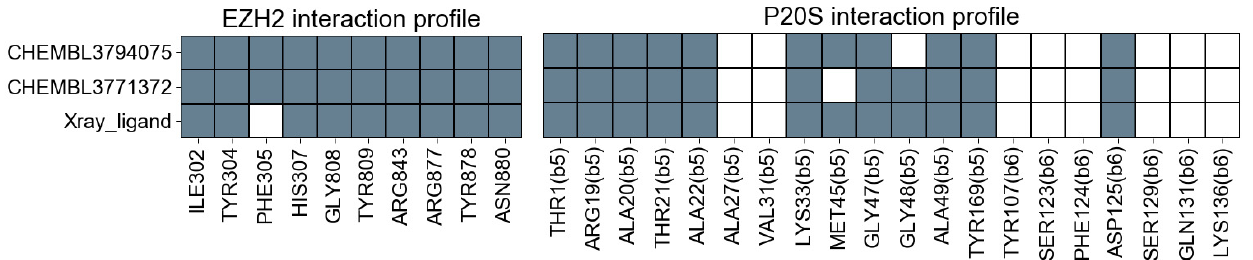
Figure 11. PLIFs profile of the contacts between the X-ray ligand and the compounds selected, and the proteins in the molecular docking simulations, calculated in Schrödinger. The profiles for the two docking hits correspond to the top-scoring pose obtained with